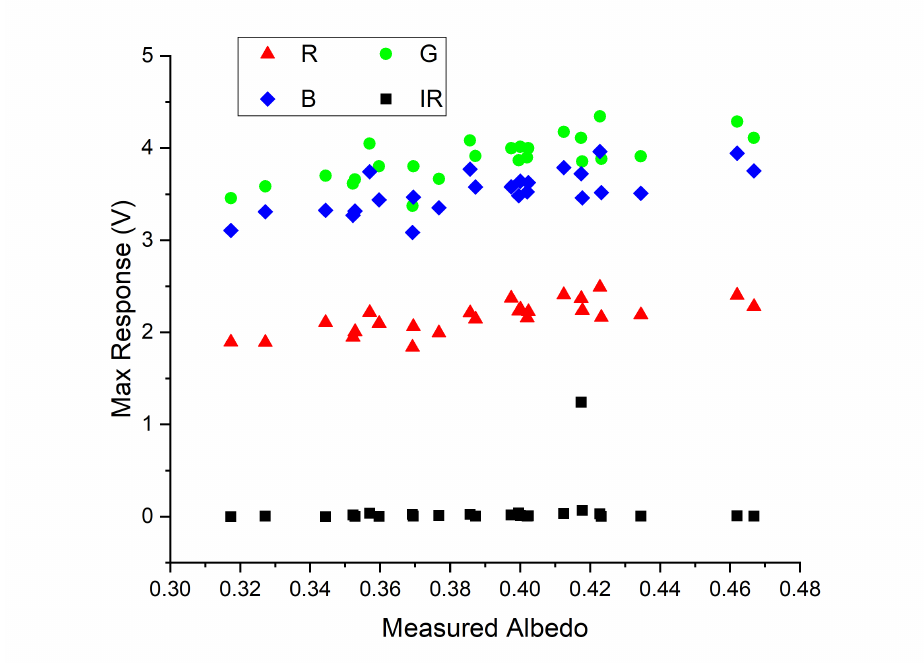
Figure 6. Maximum reflected radiation responses for each calibration